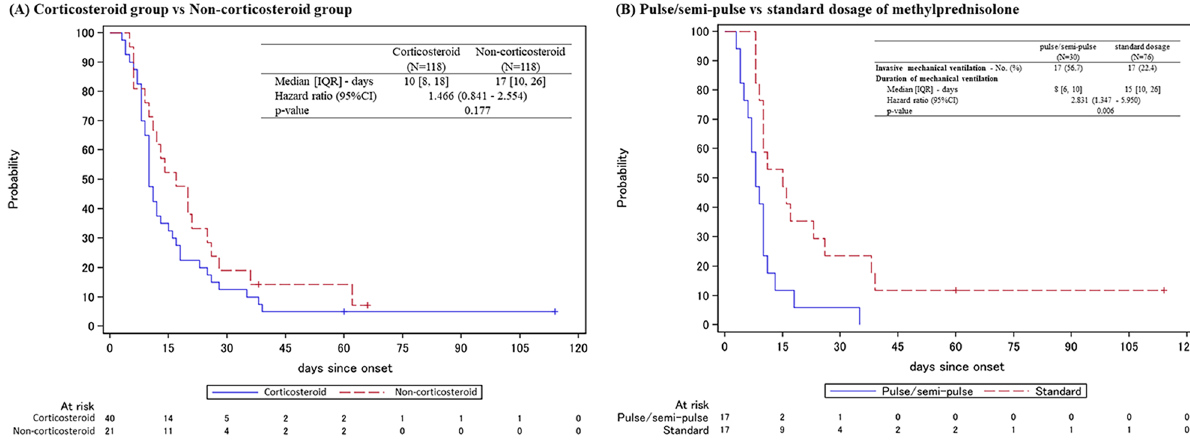
Figure 4. Duration of Invasive Mechanical Ventilation. ( A ) Kaplan–Meier curves for the duration of invasive mechanical ventilation comparing corticosteroid group and non-corticosteroid group. ( B ) Kaplan–Meier curves for the duration of invasive mechanical ventilation comparing the pulse/semi-pulse group (initial dose ≥ 250 mg/ day) and the standard dose group (initial dose < 250 mg/day) among patients receiving methylprednisolone. Cox proportional hazards model was used to calculate the hazard ratio and its 95% confidence interval for the treatment effect between groups. IQR, interquartile ranges; CI, confidence